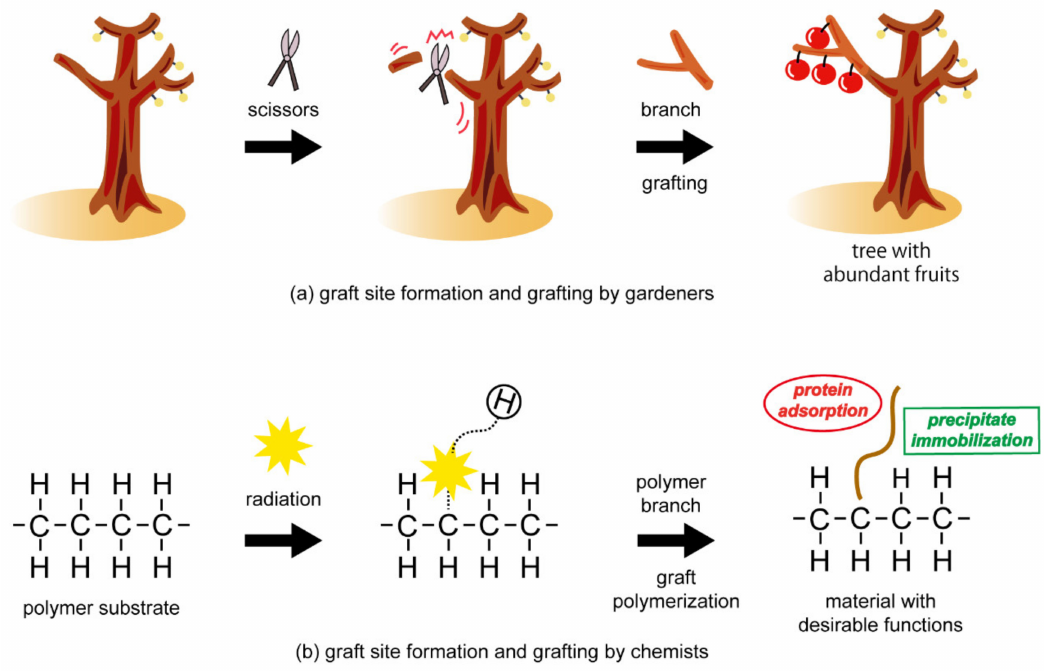
Figure 1. Analogy between graftings performed by gardeners and chemists. ( a ) Graft site formation and grafting by gardeners for production of a tree with abundant fruits, ( b ) Graft site formation and grafting by chemists for preparation of a material with desirable